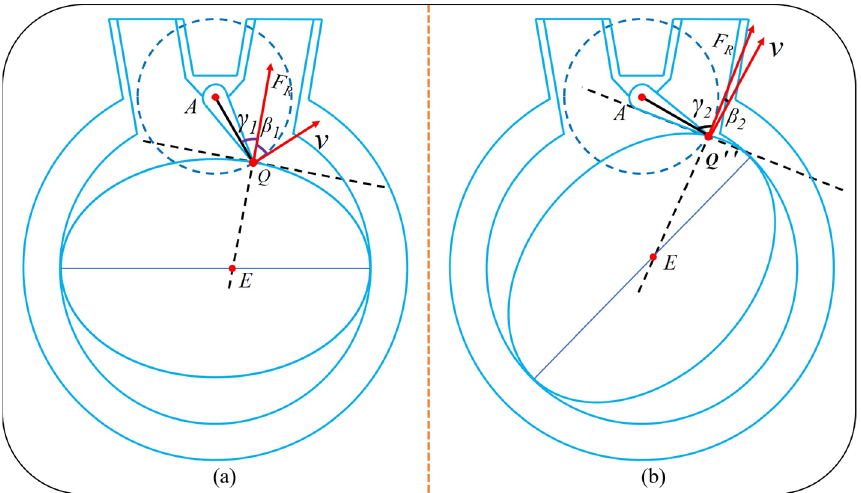
Figure 8. Schematic diagram of the swing scraper pressure angle and movement angle in different states of the elliptical rotor. ( a ) initial state; ( b ) critical state.